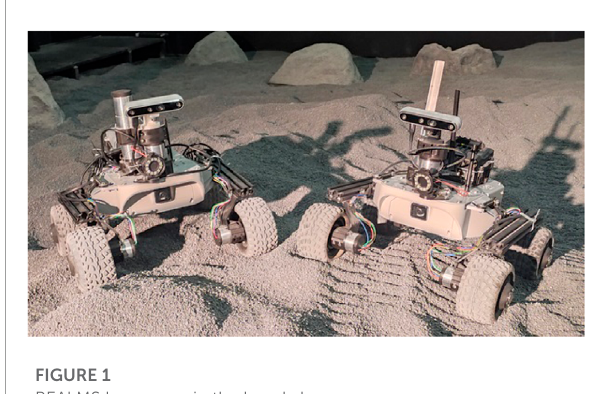
FIGURE 1 REALMS Leo rovers in the LunaLab.